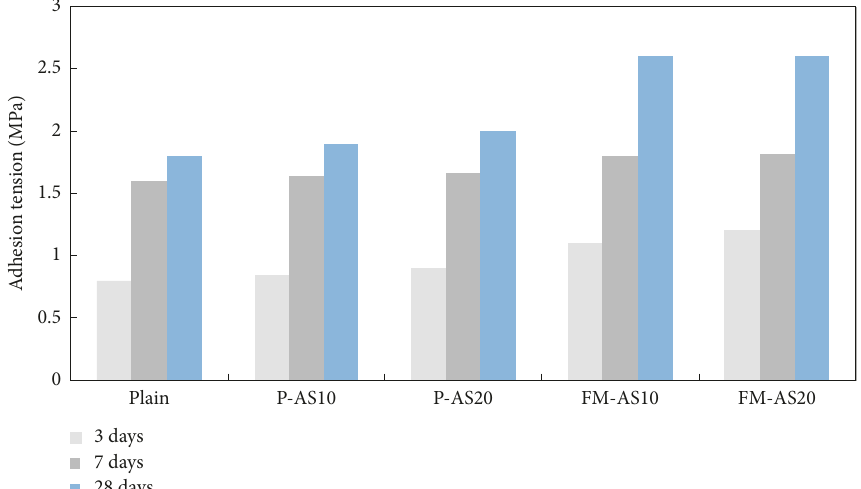
Figure 8: Adhesion tension for the cement mortar using atomizing slag-modified RMAP.